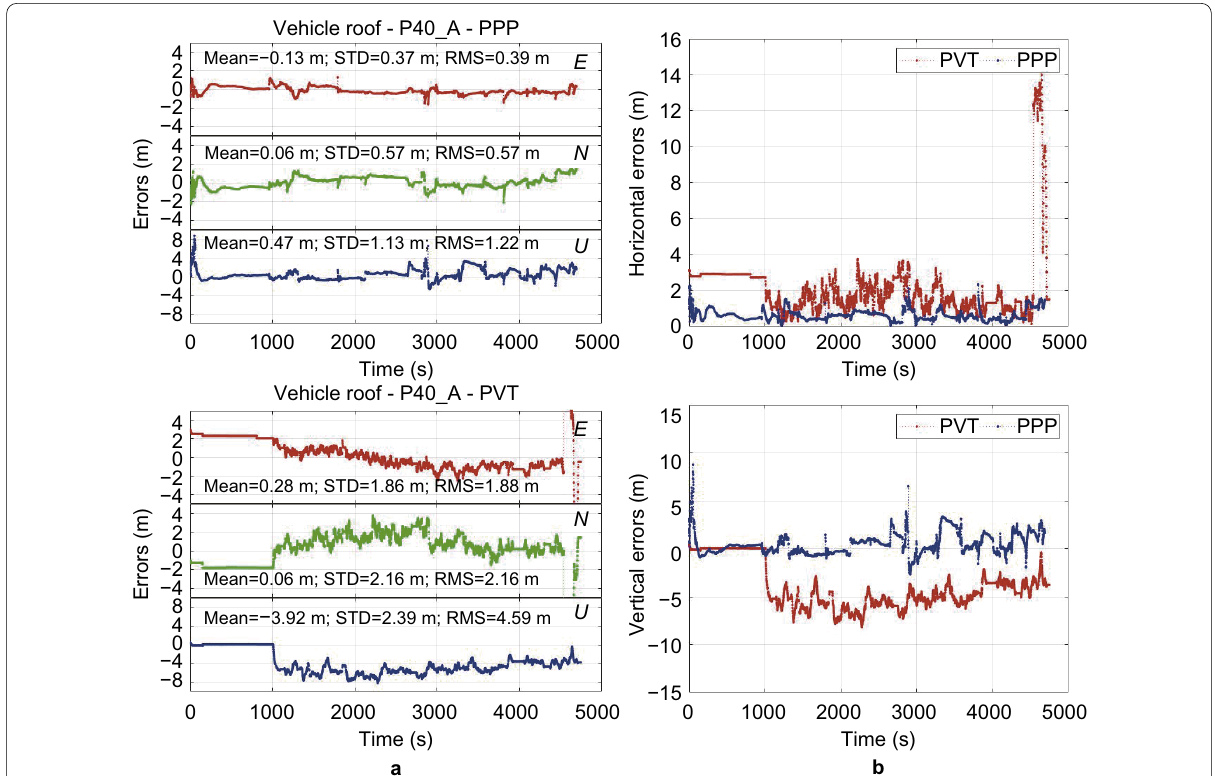
Fig. 11 The time series of the positioning errors of PPP and PVT results in a the E , N , and U components and b the horizontal and vertical directions for the P40_A smartphone in the vehicle-roof mode test